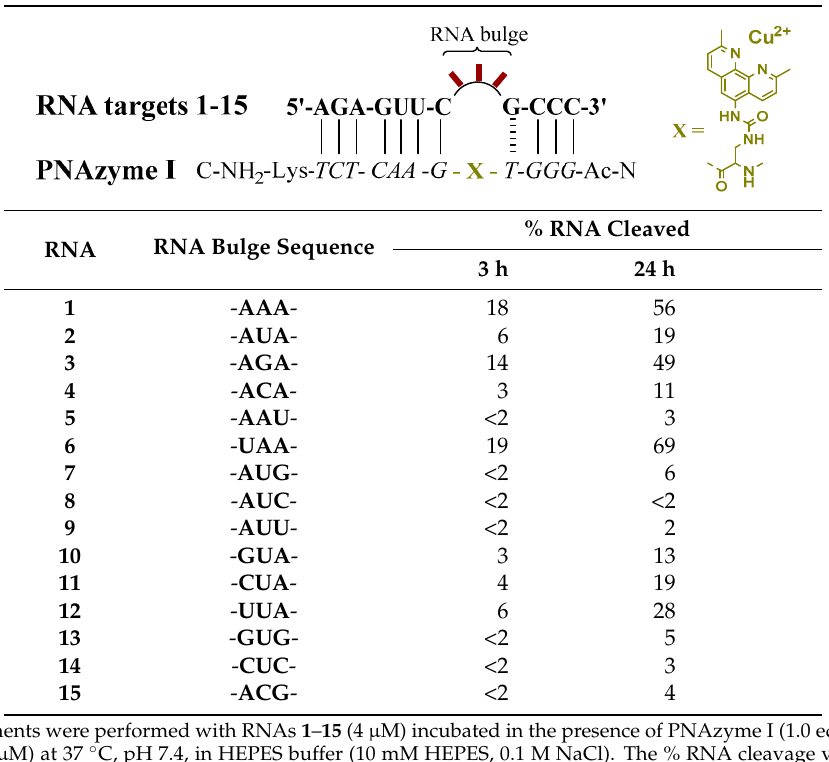
Table 1. The extent of cleavage of 3-nucleotide bulge-forming RNA sequences 1 – 15 after incubation in the presence of equimolar PNAzyme I over a period of 3 h and 24 h. 1